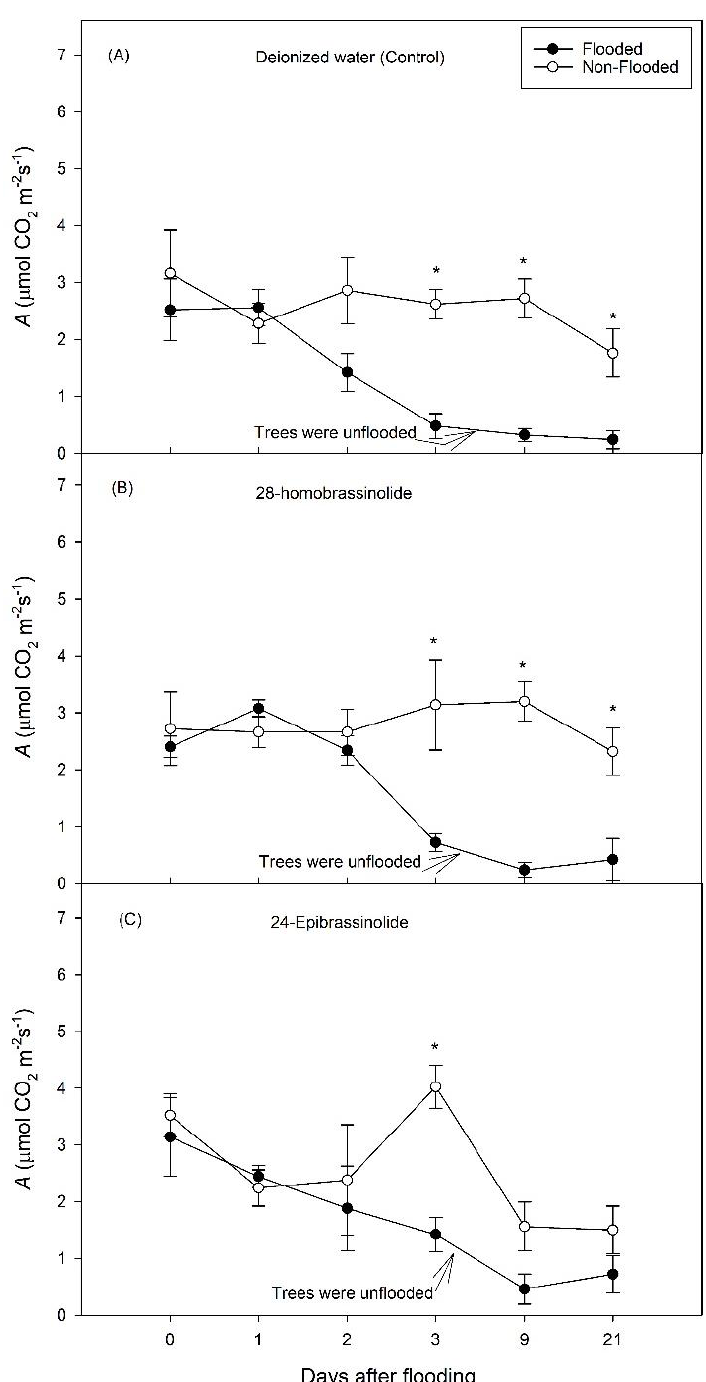
Figure 6. Effect of flooding on net CO 2 assimilation ( A ) of ‘Reed’ avocado trees treated with ( A ) deionized water as a control, ( B ) 28-homobrassinolide, or ( C ) 24-epibrassinolide, (Experiment 2). Symbols and bars indicate means ± std. err. Significant differences ( p ≤ 0.05) between flooding treatments are indicated with a single asterisk and were determined by repeated-measures ANOVA. ‘Trees were unflooded’ indicates the day on which trees were removed from the flooding treatment to start the recovery period.